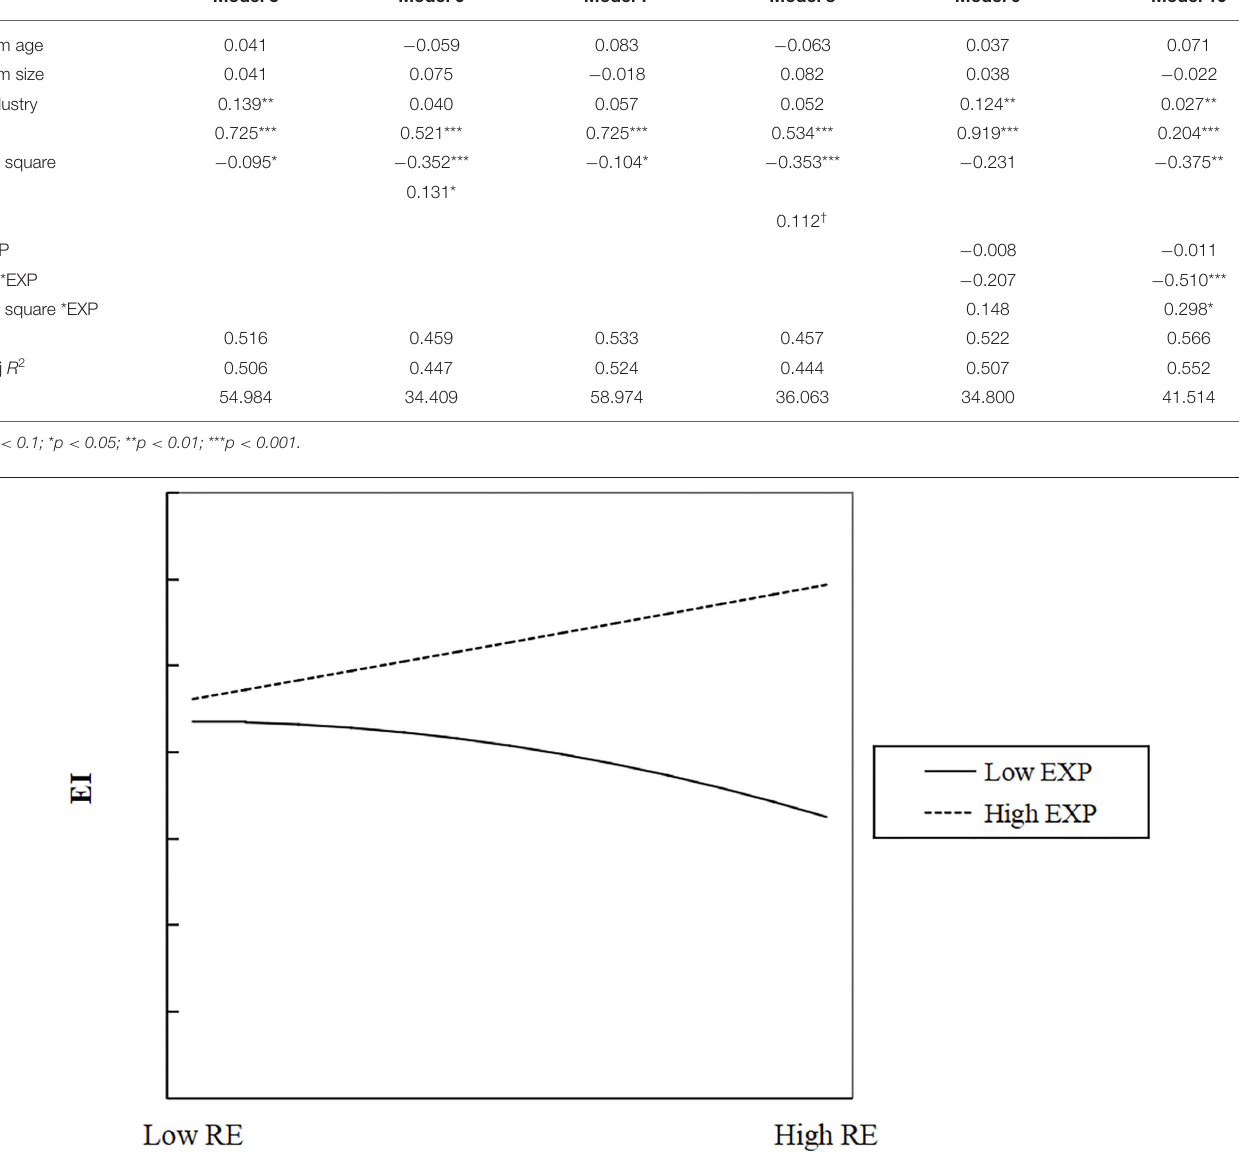
FIGURE 2 | The moderating effect of prior experience between relational embeddedness and exploitative